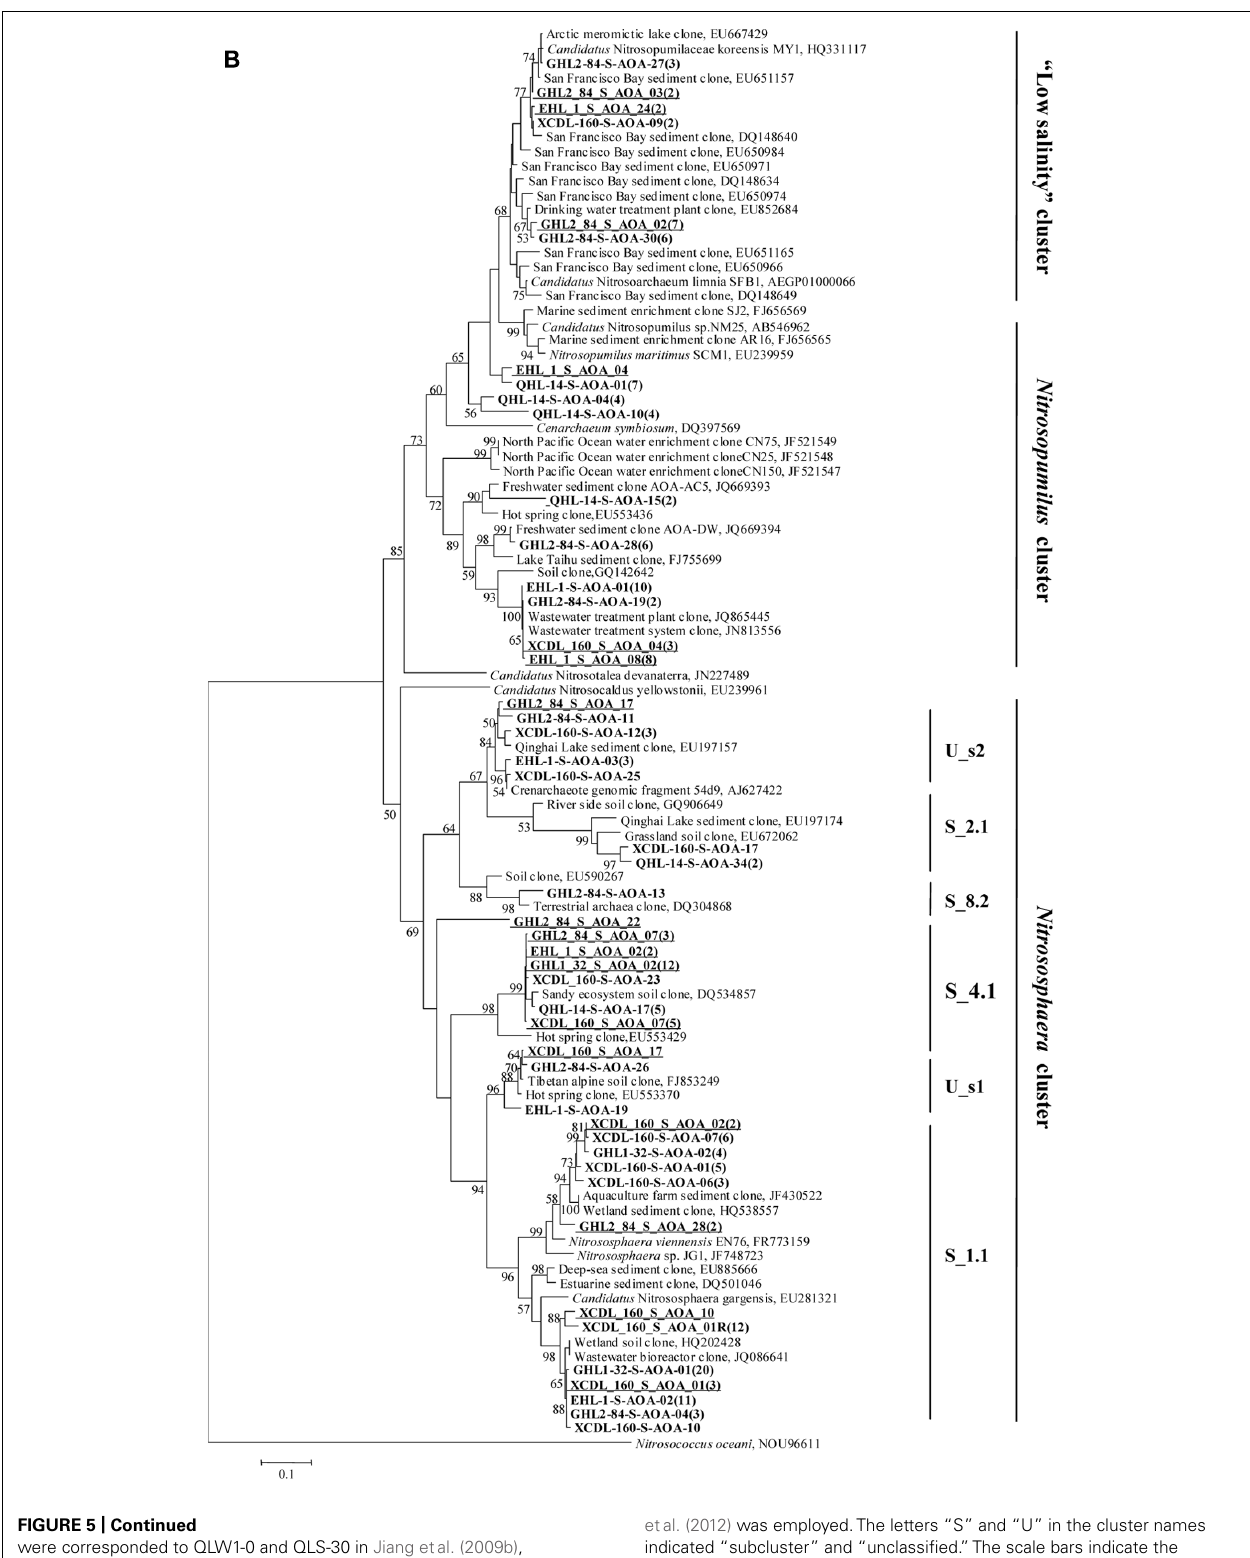
FIGURE 5 | Continued were corresponded to QLW1-0 and QLS-30 in Jiang etal. (2009b), respectively.The “R” symbol in some clone names denotes RNA-based (cDNA) clones.The underlined clone sequences were derived from the CrenamoA23f /CrenamoA616r primer set.The classification system of Pester